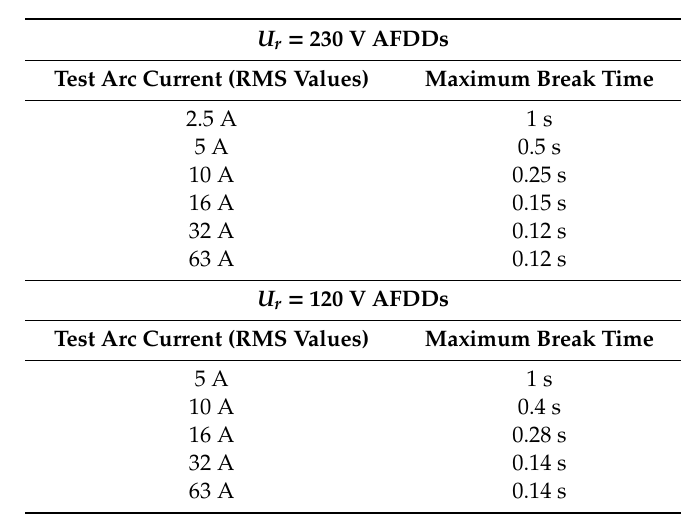
Table 2. Limit values of the break time for a series arc.